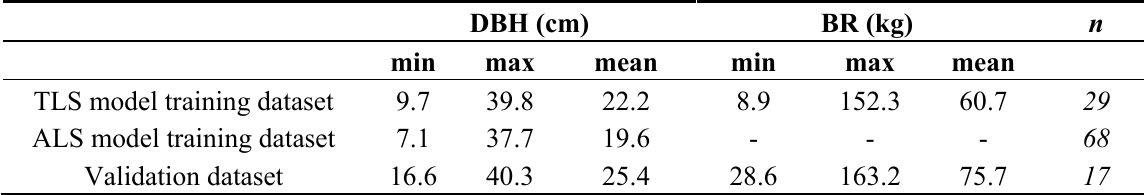
Table 1. Characteristics of the three datasets used in the present study; diameter at breast height (DBH) and field measured dry weight crown biomass